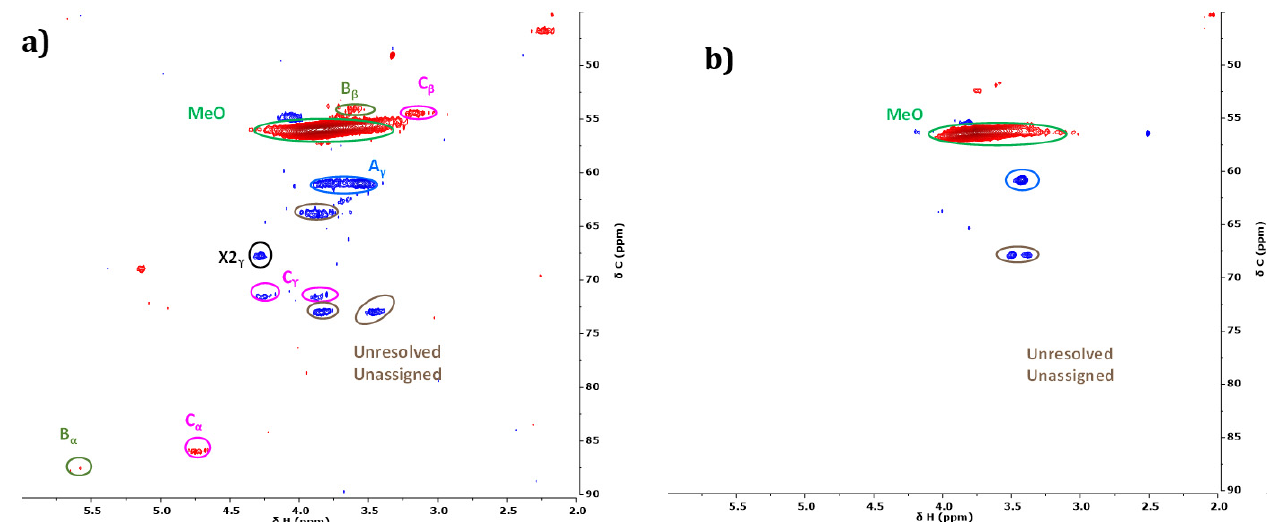
Figure 17. Side-chain region (oxygenated) of HSQC NMR spectra of initial ( a ) and organic phase after reaction without catalyst in water/EtOH ( b ).